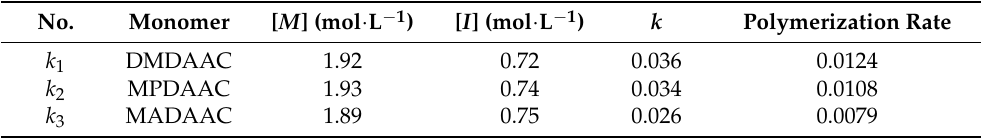
Table 8. Calculation results of polymerization rate constant k